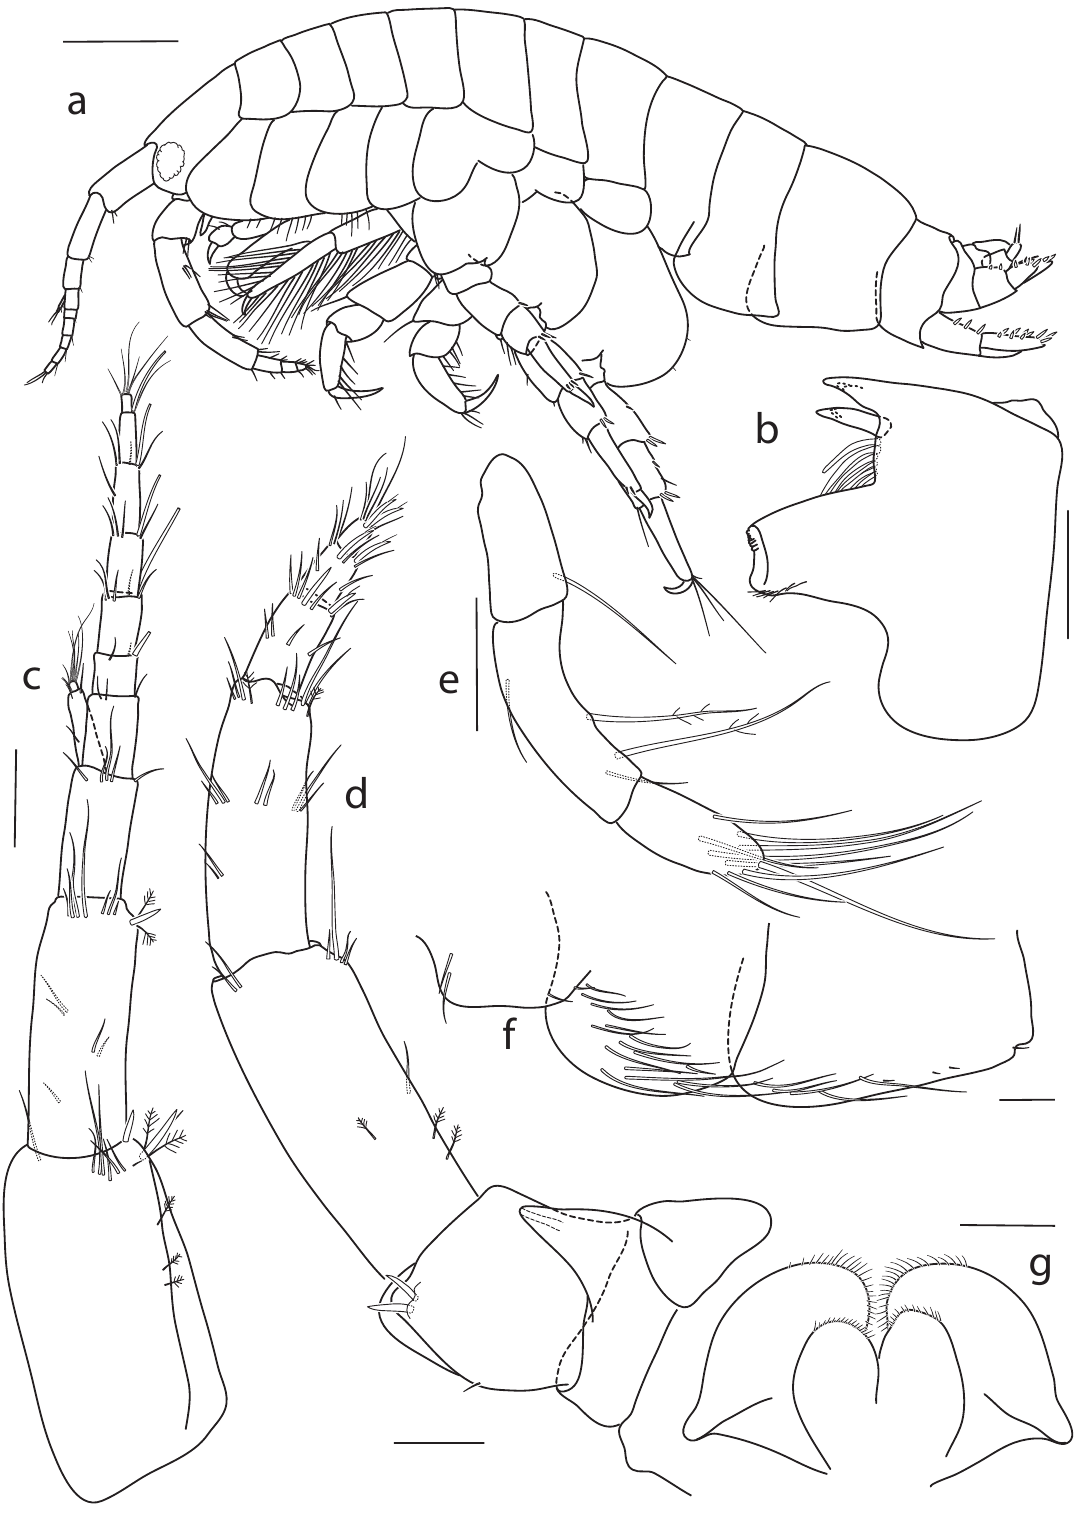
Fig. 7. Haplocheira barbimana robusta K.H. Barnard, 1932, ♂, 4.2 mm (ZMB 34098). a . Habitus, left body side. b . Mandible. c . Antenna 1. d . Antenna 2. e . Palp of mandible. f . Epimeral plates 1–3. g . Lower lip. Scale bars: a = 500 µm; b–g = 100